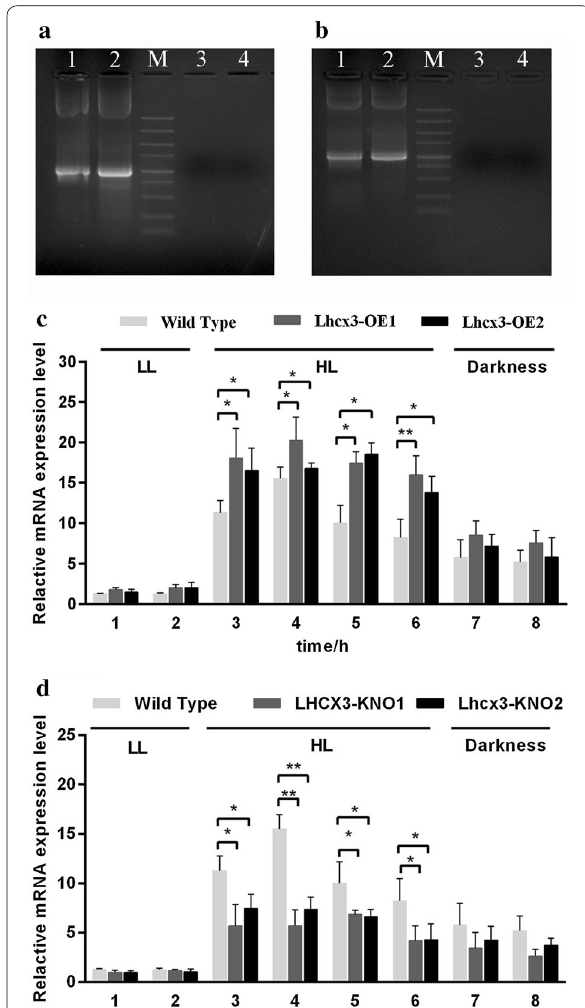
Fig. 4 Molecular characteristics of transgenic lines. a Ble gene in overexpressed lines detected by genomic PCR; Lane M: 5000 bp marker, Lane 1, 2: A 1 kb band corresponding to Ble gene; Lane 3: genomic DNA of WT cells; Lane 4: water; b Ble gene in knocked‑down lines detected by genomic PCR; Lane M: 5000 bp marker, Lane 1, 2: A 1 kb band corresponding to Ble gene; Lane 3: genomic DNA of WT cells; Lane 4: water; c Relative transcript level of Lhcx3 in overexpressed lines (OE1 and OE2) and wild type. Significant difference between WT and transgenic lines is indicated at P <